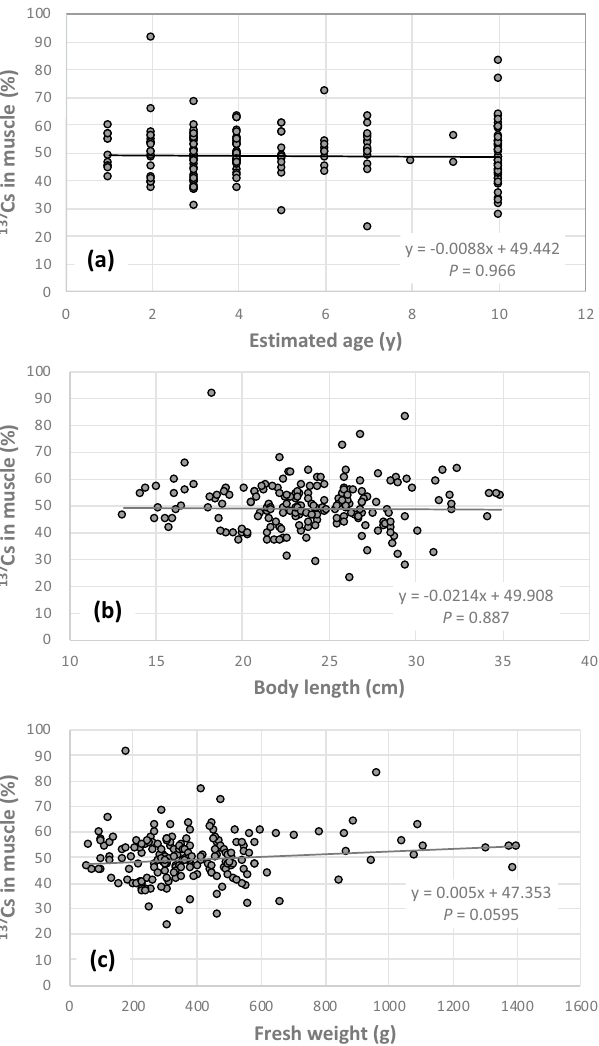
Figure 4. Relationships between the indexes of the growth and the proportion of 137 Cs in muscle of crucian carp. The estimated ( a ) age, ( b ) body length, and ( c ) fresh weight were used as the indexes. The number of samples was 197. No correlations were observed for any